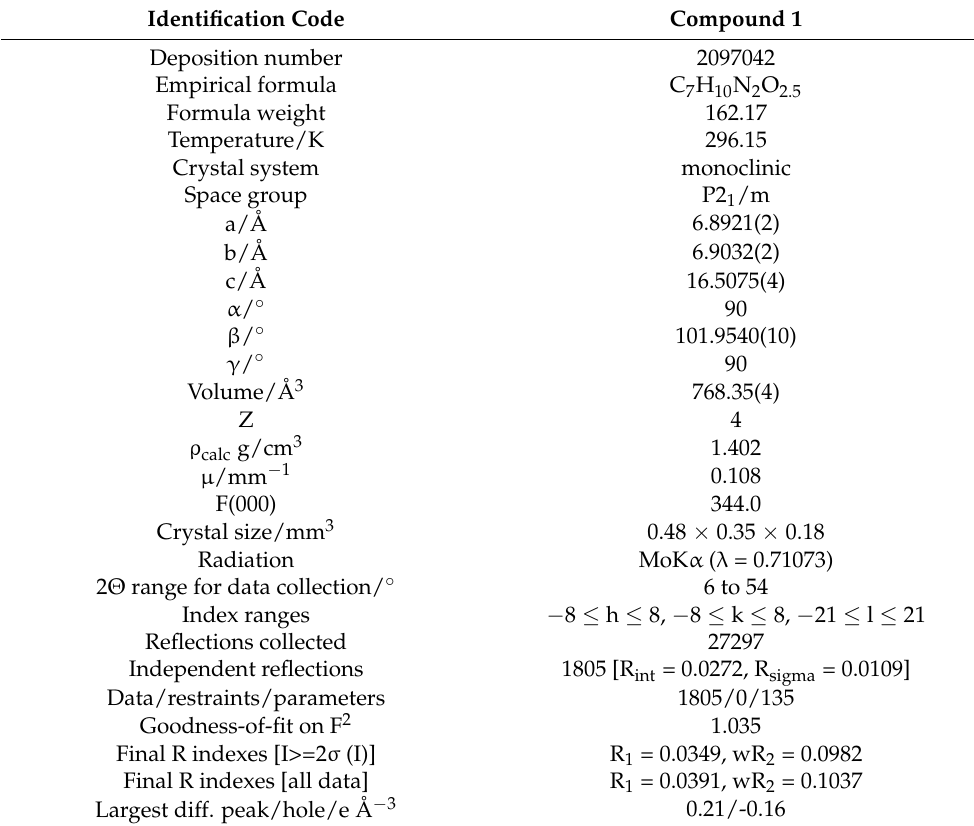
Table 1. Crystal data and structure refinement for compound 1